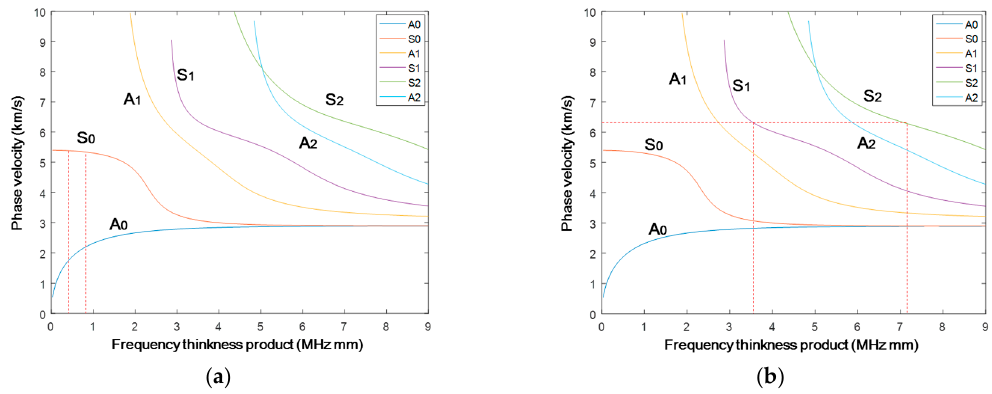
0 -S 0 and S 1 -S 2 .